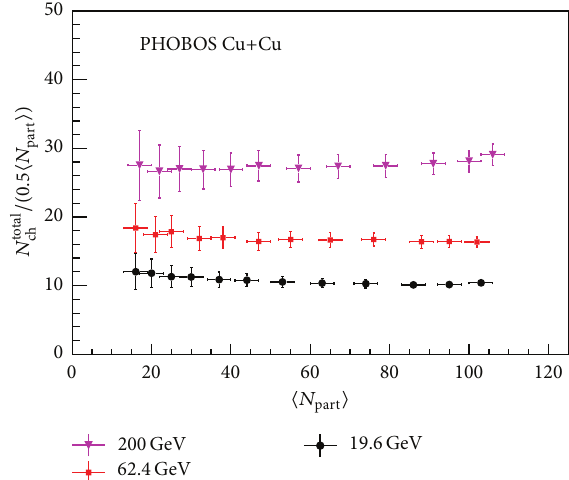
Figure 19: 𝑁 total normalized to participant pair as a function of 𝑁 ch for Cu+Cu collisions at different collision